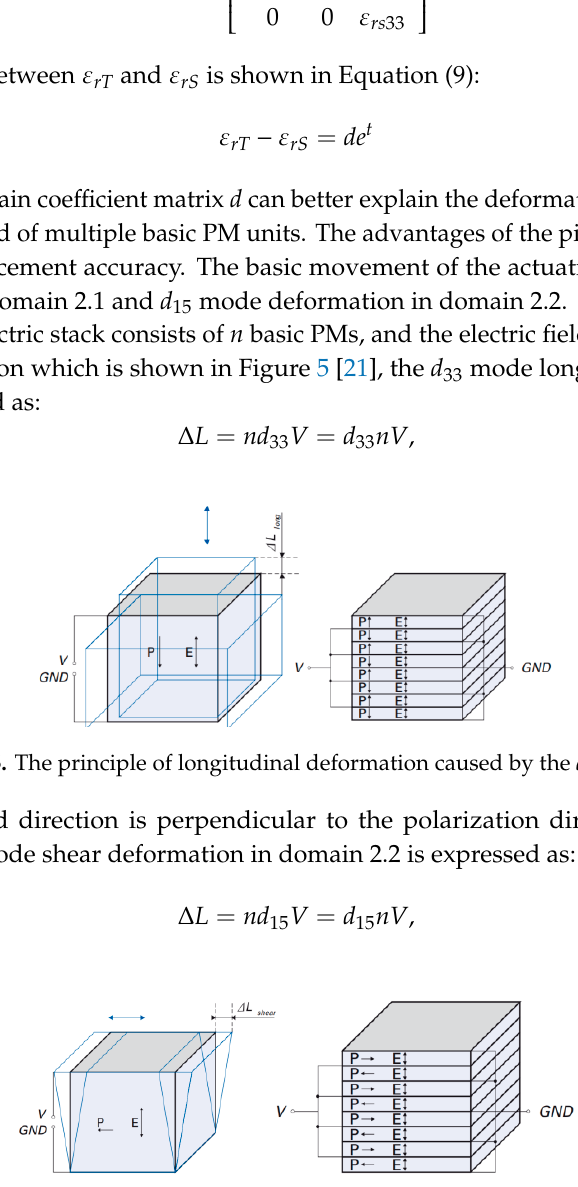
Figure 6. The principle of shear deformation caused by the d 15 mode.